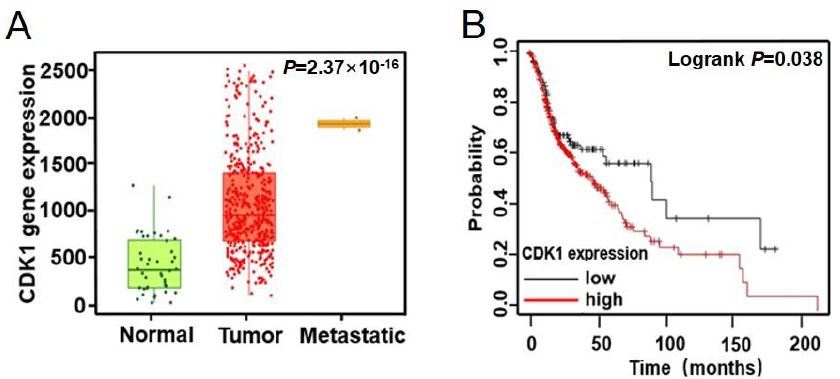
Figure 4. CDK1 is upregulated in head and neck squamous cell carcinomas (HNSCCs) and is correlated to malignant progression of HNSCCs. ( A ) CDK1 expression in HNSCCs and normal tissues, as well as metastatic HNSCCs, was analyzed in website http://www.kmplot.com (accessed on 18 February 2021). ( B ) The survival analysis of HNSCC patients with high or low CDK1 expression was performed in website http://www.kmplot.com (accessed on 18 February 2021).